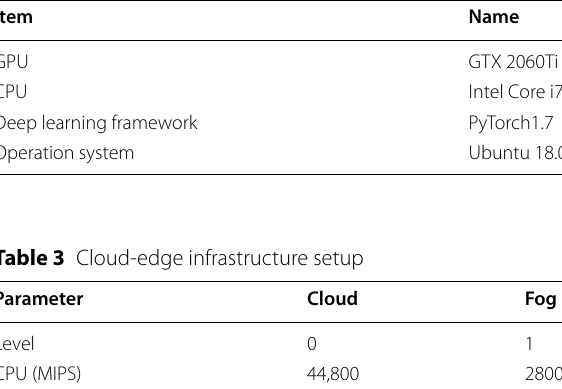
Table 2 Experimental environment